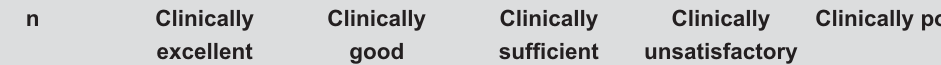
Table 1- Six-months clinical evaluation of restorations: functional